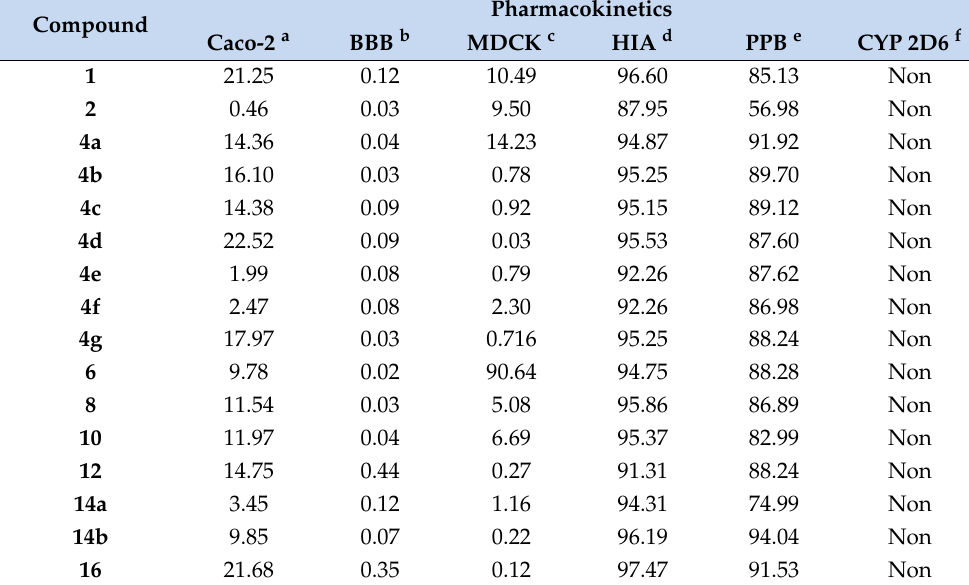
Table 4. List of ADME properties of compounds 1 , 2 , 4a – g , 6 , 8 , 10 , 12 , 14a , b , and 16 .